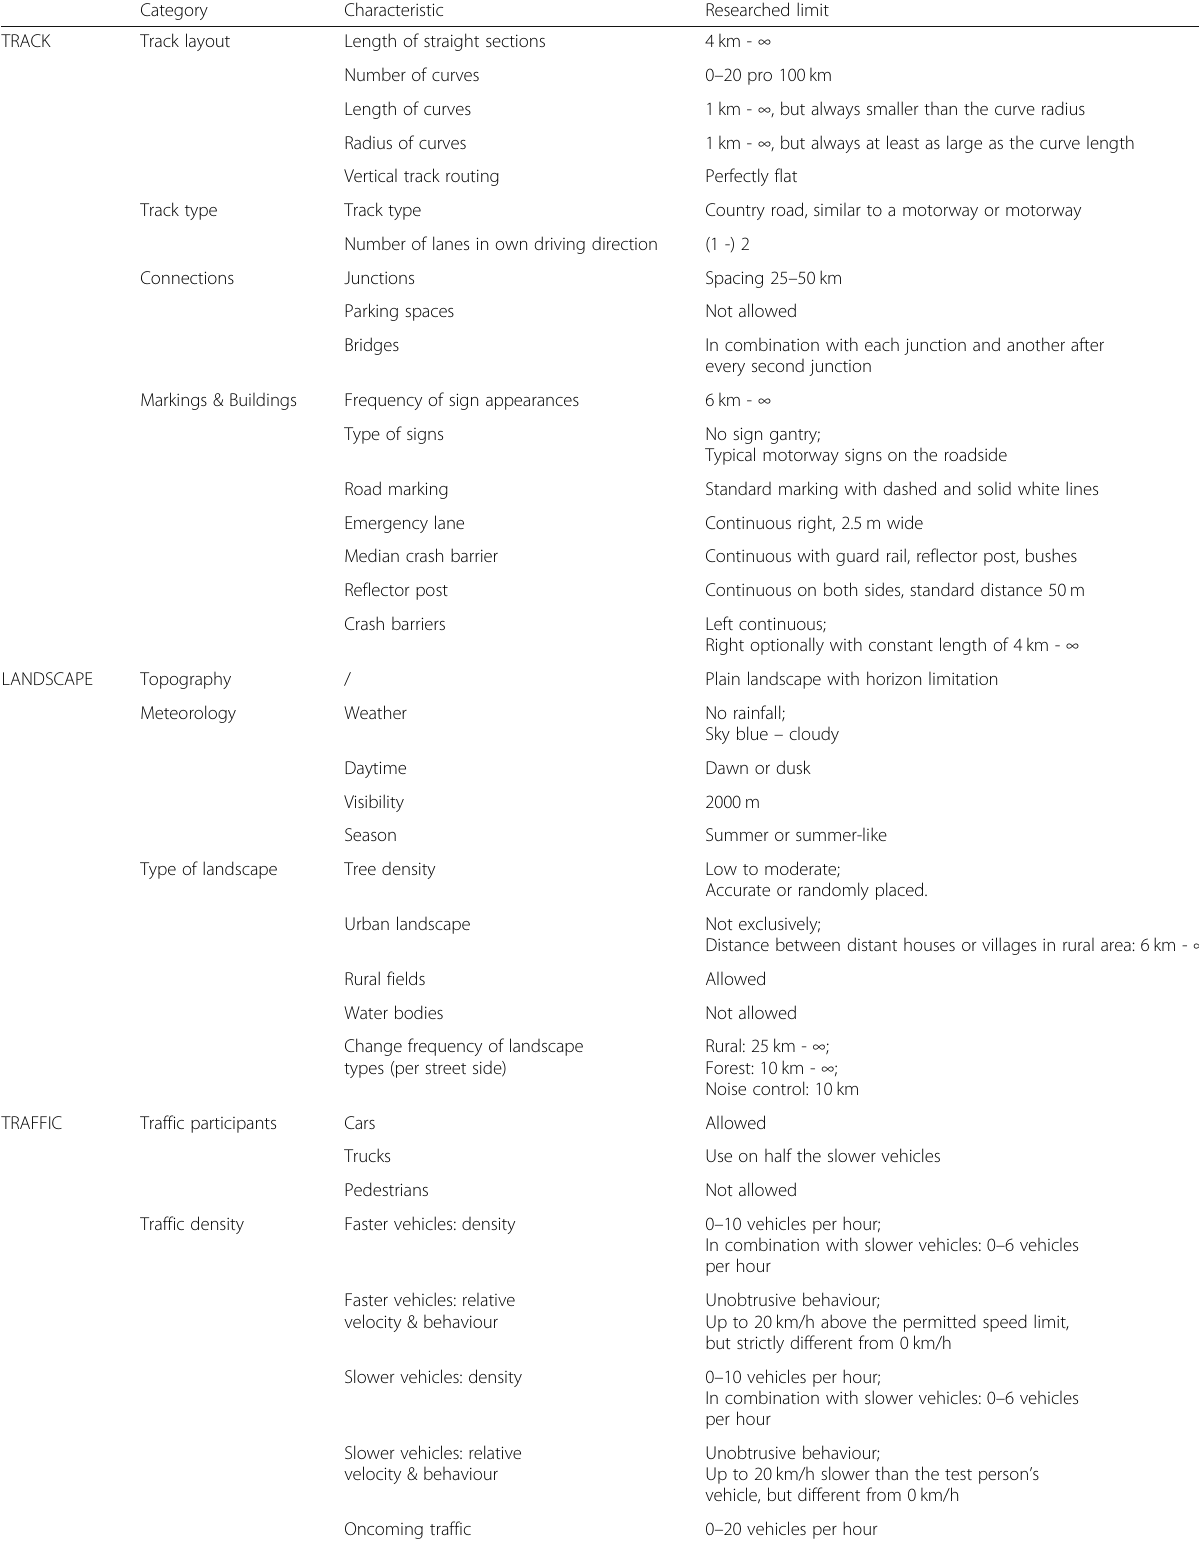
Table 2 Limit values of a monotonous route